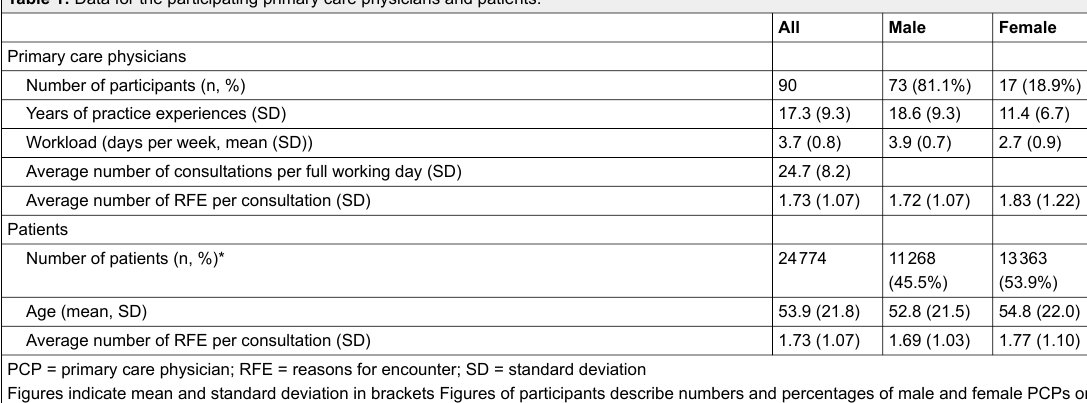
Table 1: Data for the participating primary care physicians and